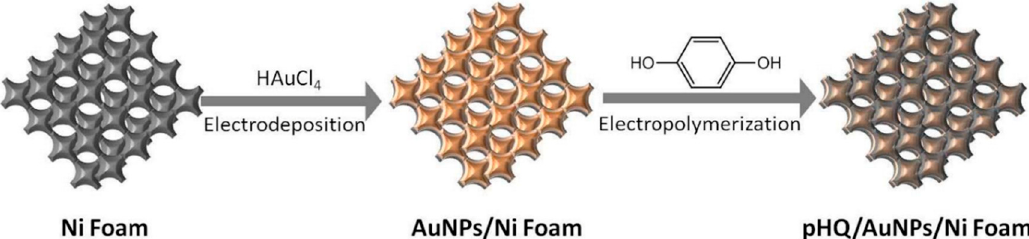
Figure 8. Schematic representation of the fabrication process of pHQ/AuNPs over Ni Foam. Reproduced with permission from [125]. Copyright 2017 Elsevier B.V.